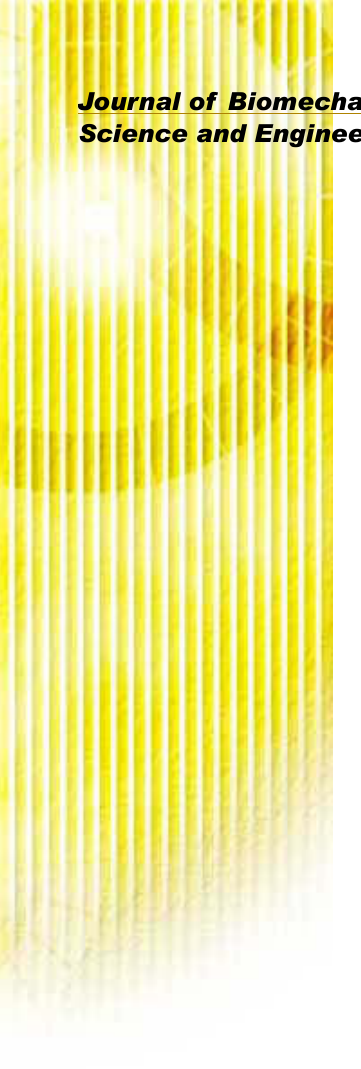
Fig. 3 (a) Creep test results showing that the strain of the liver sample increased over a time interval of 180 s. The blue plot shows the experimental results, and the red line is the response of our model. (b) Creep test results showing that the model response did not closely represent the vibration of the experimental result. The blue line shows the experimental results. The red line is the model